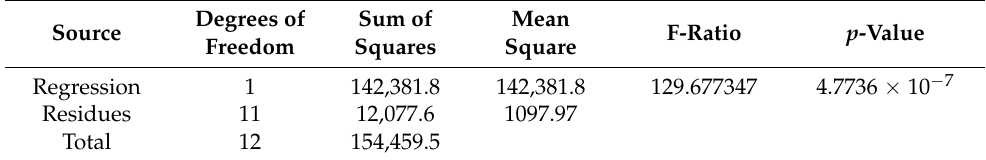
Table 12. ANOVA for model analysis.